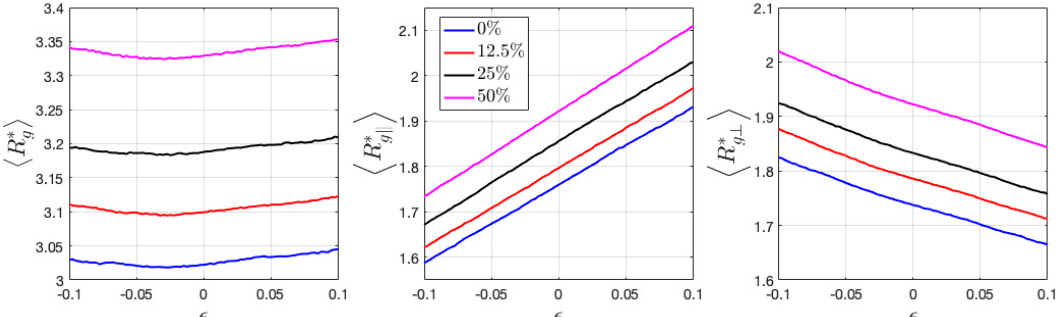
(cid:105) and g (cid:107)